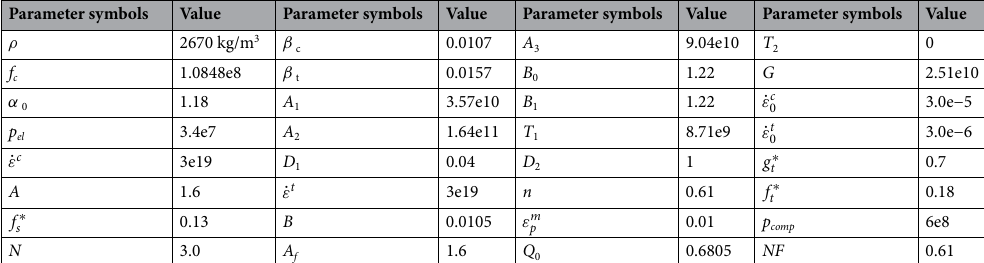
Table 2. The key material parameters of rock properties in the numerical simulation.